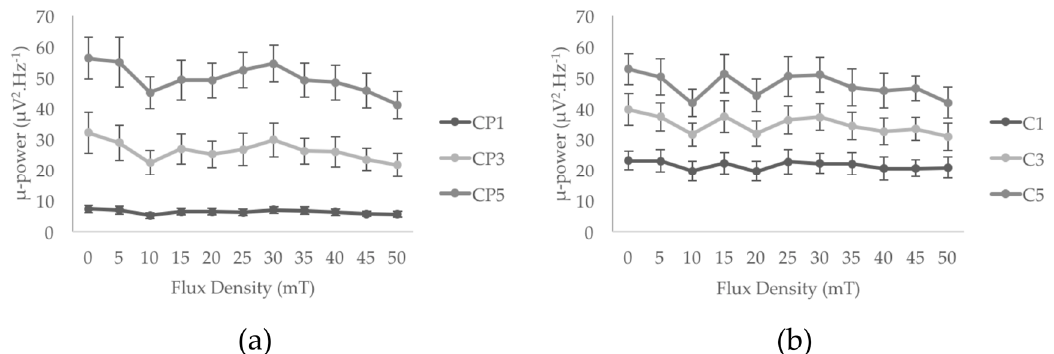
Figure 5. Mu-rhythm (8 to 12 Hz) spectral power: in CP1, CP3, and CP5 ( a ); and in C1, C3 and C5 ( b ) electrodes. CP3 and CP5 electrodes show a significant main MF effect suggesting a decrease of mu-rhythm amplitude associated with increasing flux density (although not confirmed by post-hoc pairwise comparisons). Each data point represents average values calculated on the ten participants for each MF exposure condition (from 0 to 50 mT rms ). Error bars represent standard error of the mean.